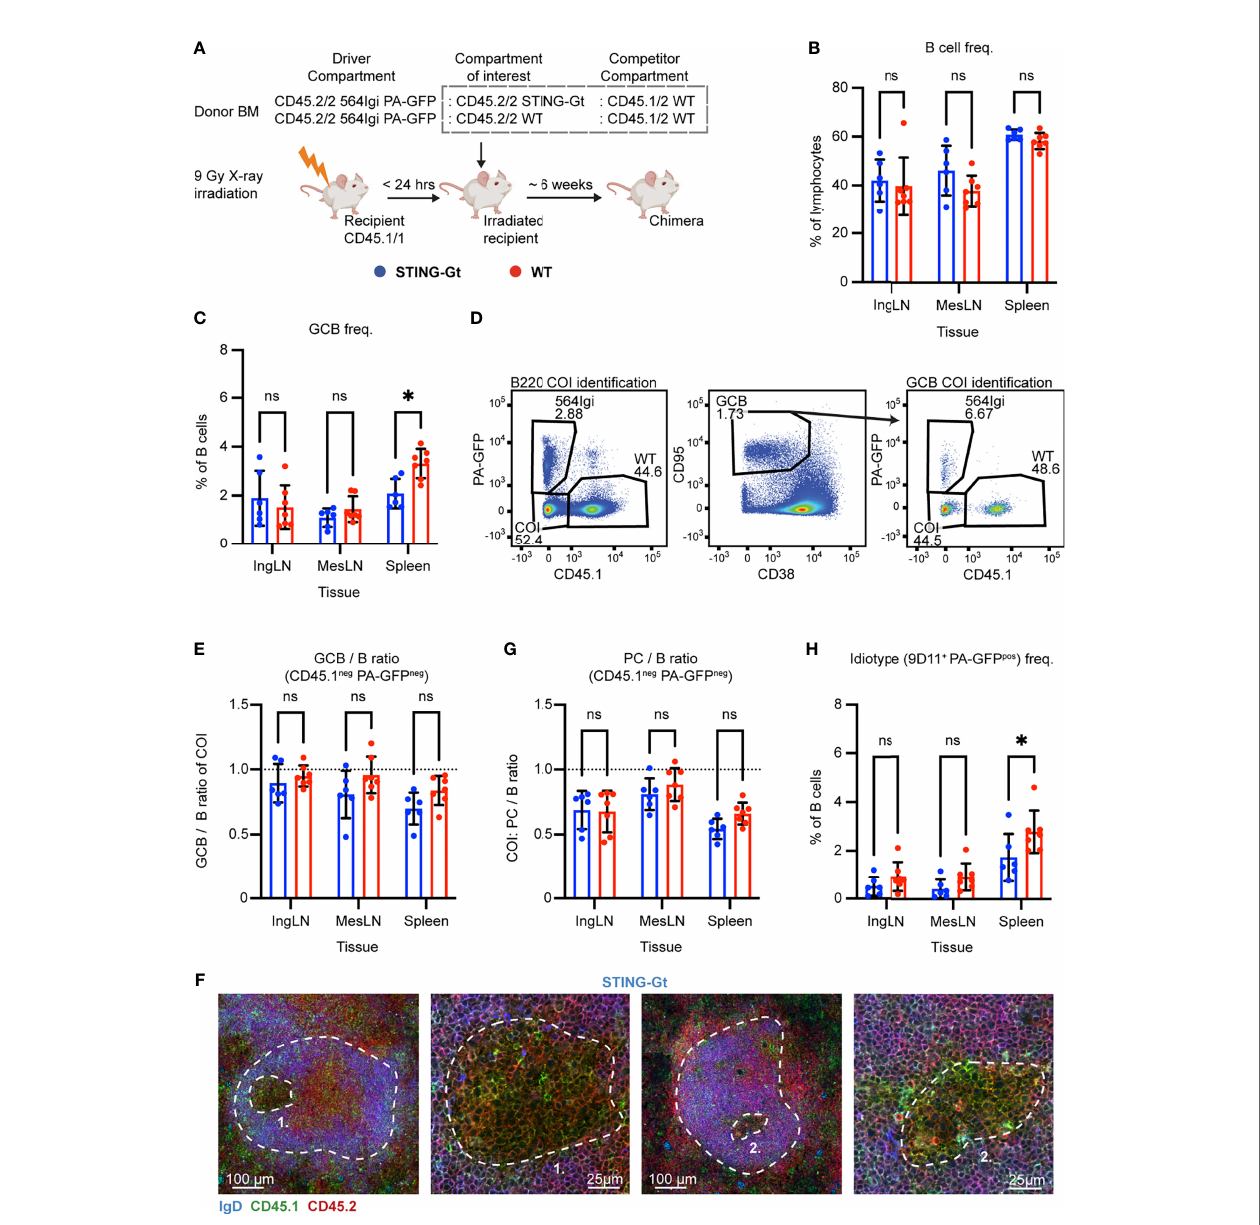
FIGURE 3 | Unique identi fi cation of STING-Gt cells recapitulates the fi nding that B cell intrinsic STING signaling is not required for autoreactive germinal center participation. (A) Schematic overview of experimental setup with timeline. (B) B cell frequencies out of live, singlet lymphocytes, in lymphoid tissues of STING-Gt (blue, n = 6) and WT (red, n = 7) chimeras. Each dot represents an individual mouse and bars indicate mean +/- SD, with statistical signi fi cance given for two-way ANOVA followed by Sidak ’ s post-test ( a = 0.05), ns = not signi fi cant, * = p<0.05. (C) As in (B) , but for GCB cell frequencies instead. (D) Representative example from a STING-Gt chimera showing gates used to de fi ne CD45.1 vs. PA-GFP within the B cell (left) and GCB cell (right) compartments, and the parent GCB cell gate (center). (E) As (B) but showing relative GCB to B cell ratios for the compartment of interest (COI, CD45.1 - PA-GFP - ). (F) Confocal micrographs of spleen sections from a representative STING-Gt chimera stained for IgD (naïve B cells, blue), CD45.1 (green), CD45.2 (red) and the marginal zone (CD169, not shown). From left, lower magni fi cation image with indication of the marginal zone (broken white line, based on CD169 staining, Figure S3J ) and a GC (numbered), followed by a higher magni fi cation image of that GC. Then another lower magni fi cation image with indication of the marginal zone (broken white line, based on CD169 staining, S3J), and a GC (numbered), followed by a higher magni fi cation image of that GC. Channel assignments and brightness were adjusted to enhance visual clarity of micrographs. (G) As (E) but showing relative PC (plasma blast/cell, CD138 hi within live, singlet lymphocytes) to B cell ratios for the compartment of interest (COI, CD45.1 - PA-GFP - ). (H) As (B) , but for 564Igi idiotype (9D11 + ) frequencies of PA-GFP positive B